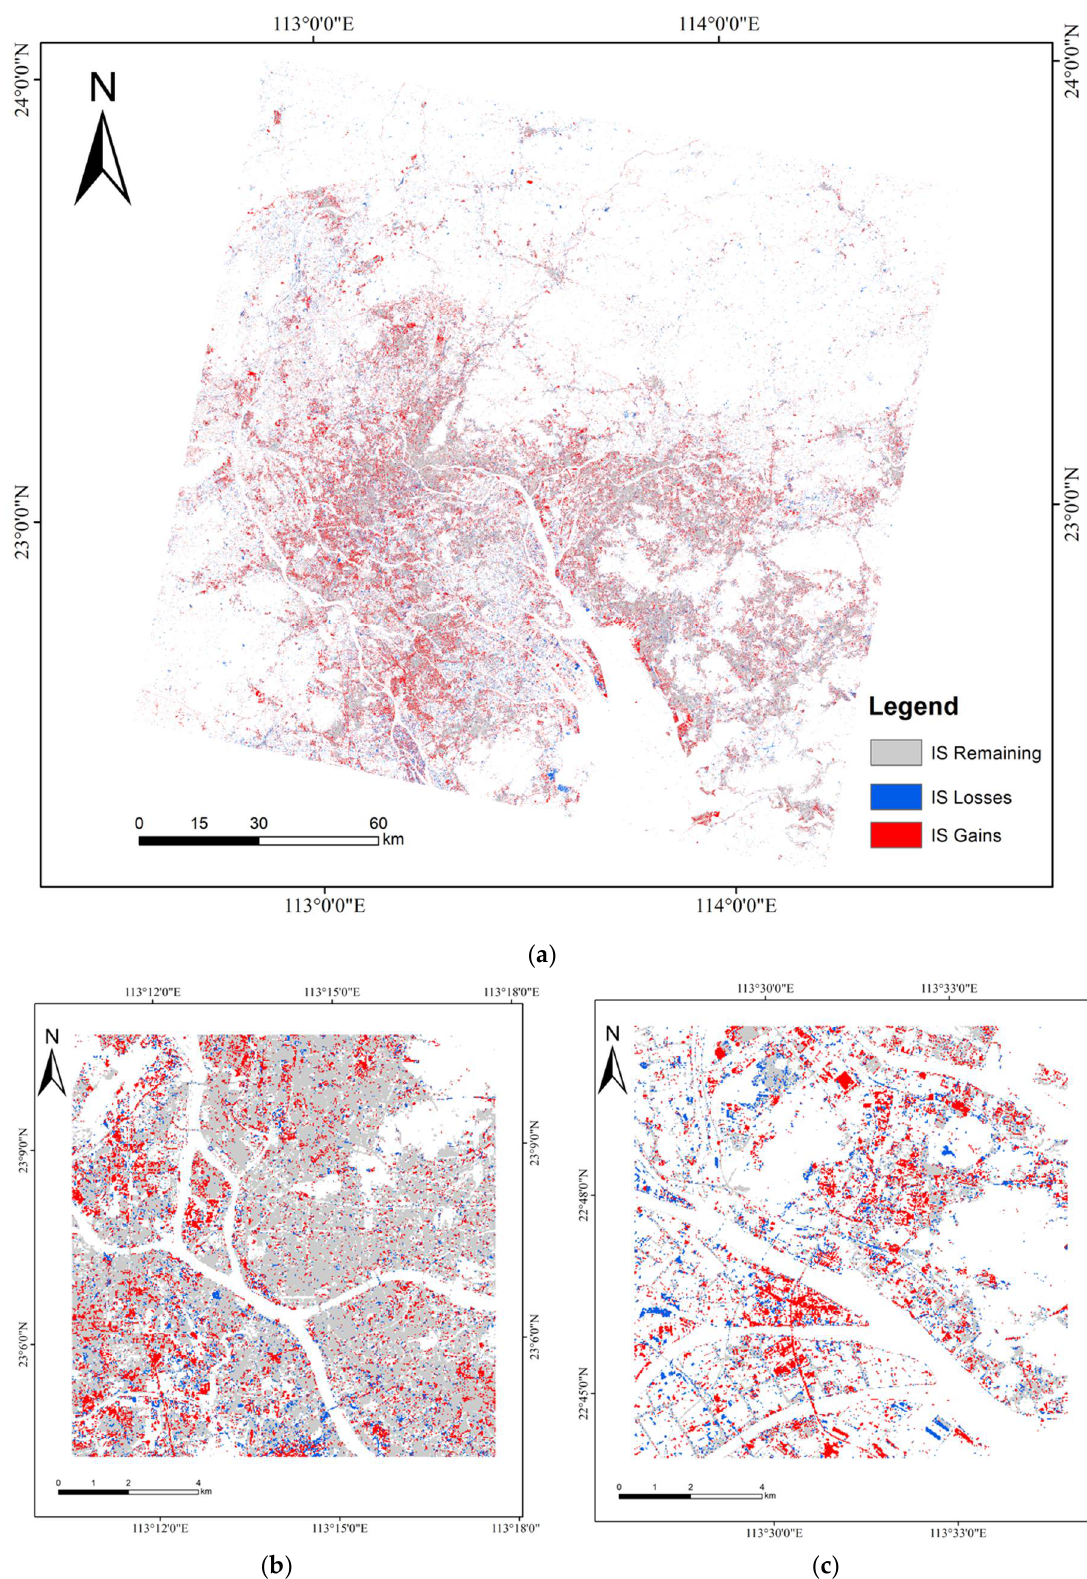
Figure 4. ( a ) The overall map of change and no-change (in white) for Impervious Surface; ( b ) detail in Region 1; and ( c ) detail in Region 2.